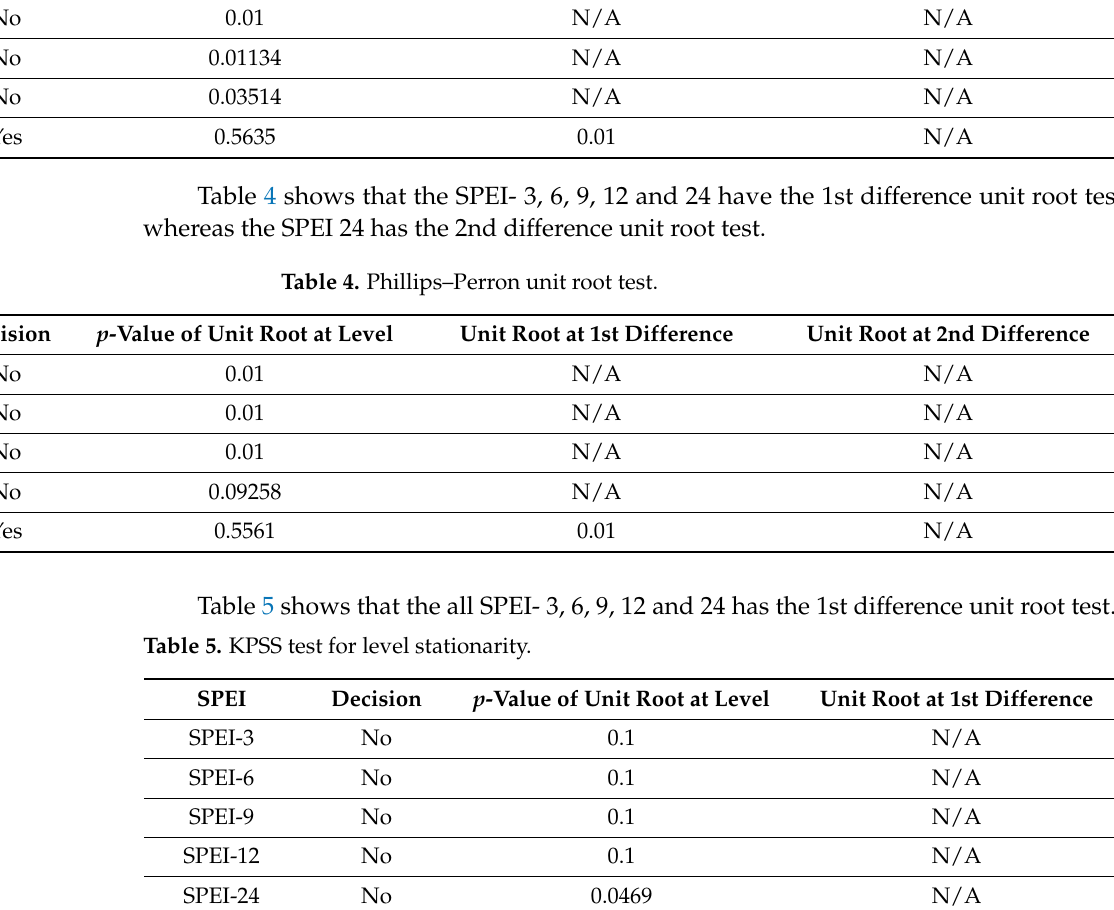
Table 3. Augmented Dickey–Fuller test.